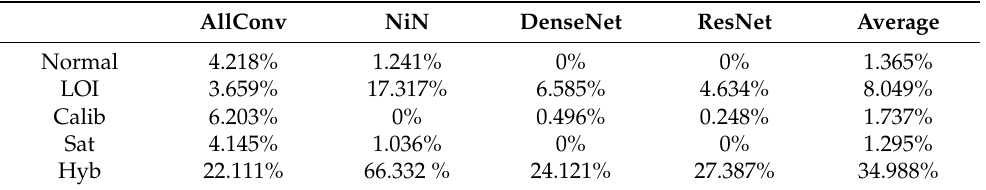
Table 4. The probability of being attacked under non-target attack (1 pixel). AllConv: all convolution network. NiN: Network in Network. Normal: the unattacked state. LOI: LO intensity attacks. Calib: calibration attacks. Sat: saturation attacks. Hyb: the hybrids attacks. AllConv NiN DenseNet ResNet Average Normal 69.07% 90.72%